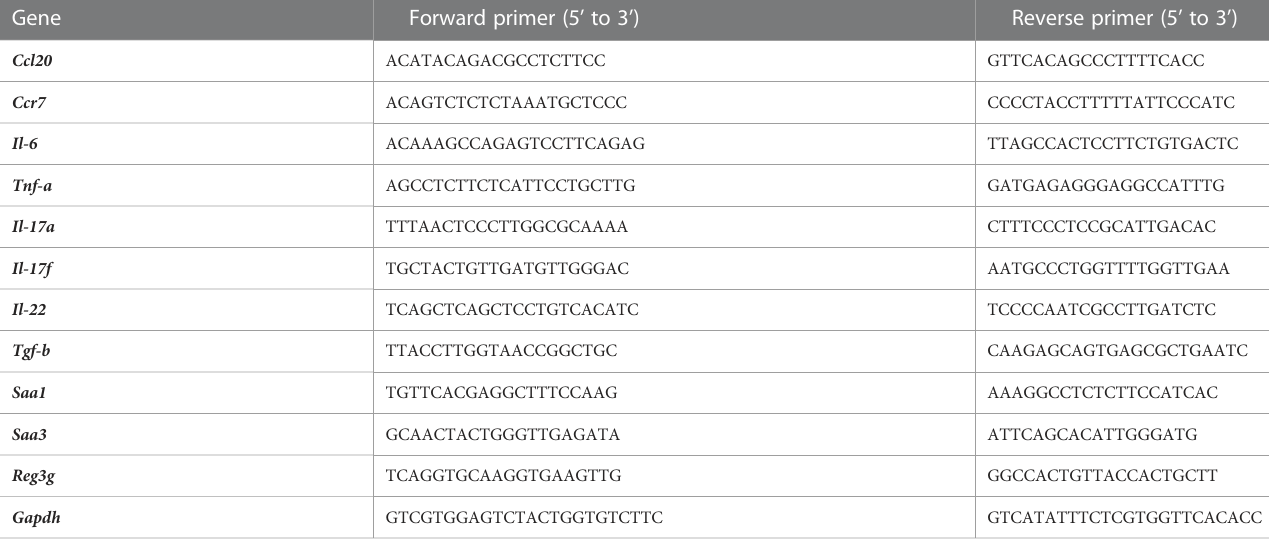
TABLE 1 Primer sets used for qRT-PCR.